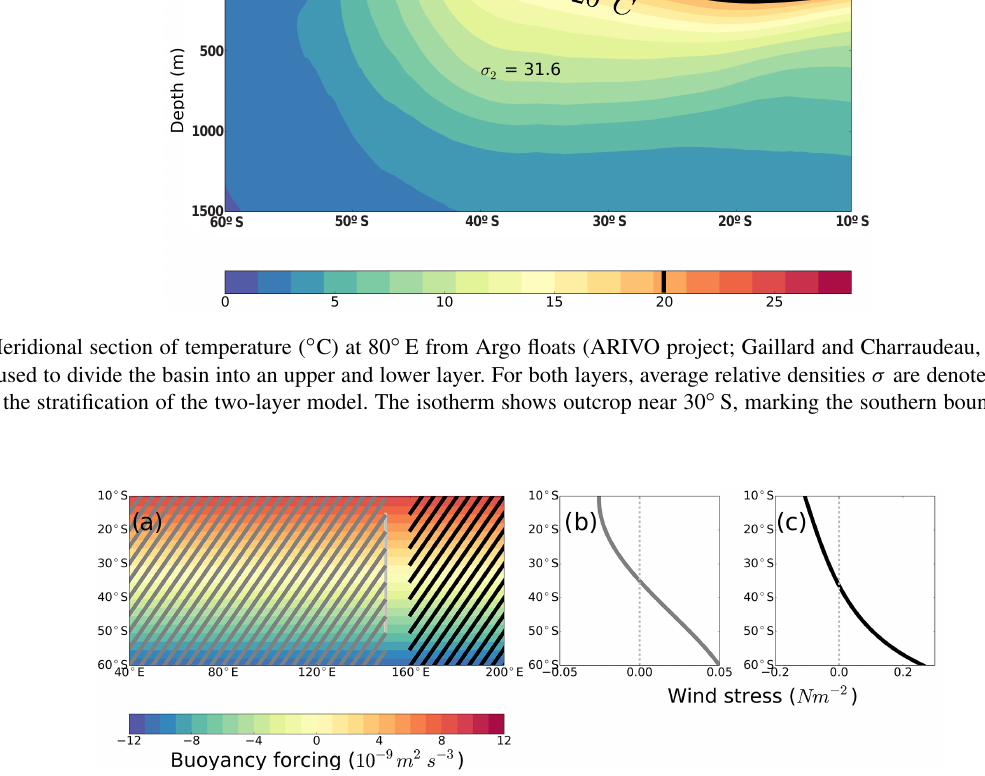
tion. An elongated island is chosen to represent